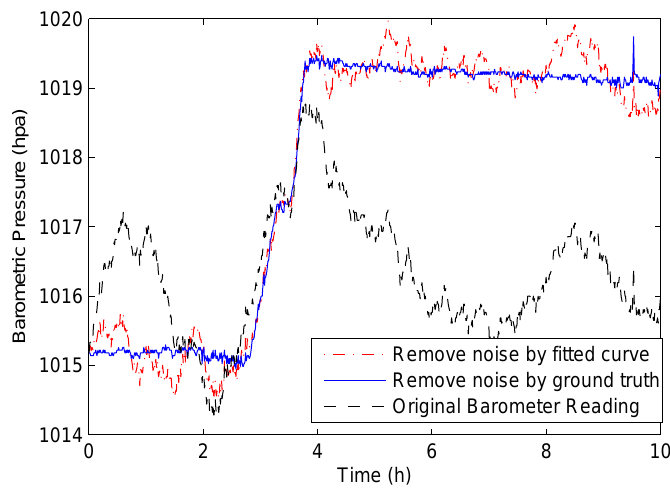
Figure 4. Filtering noise caused by